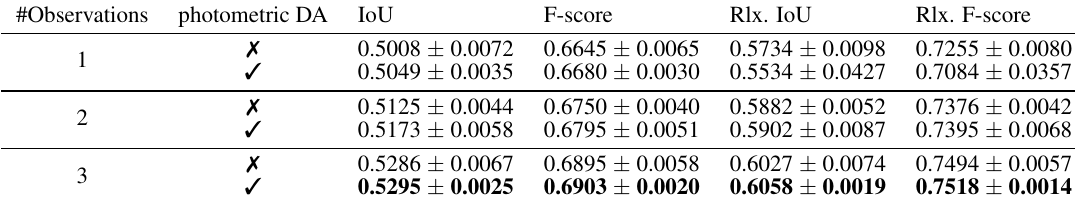
Table 4. Results obtained in test set for the road extraction